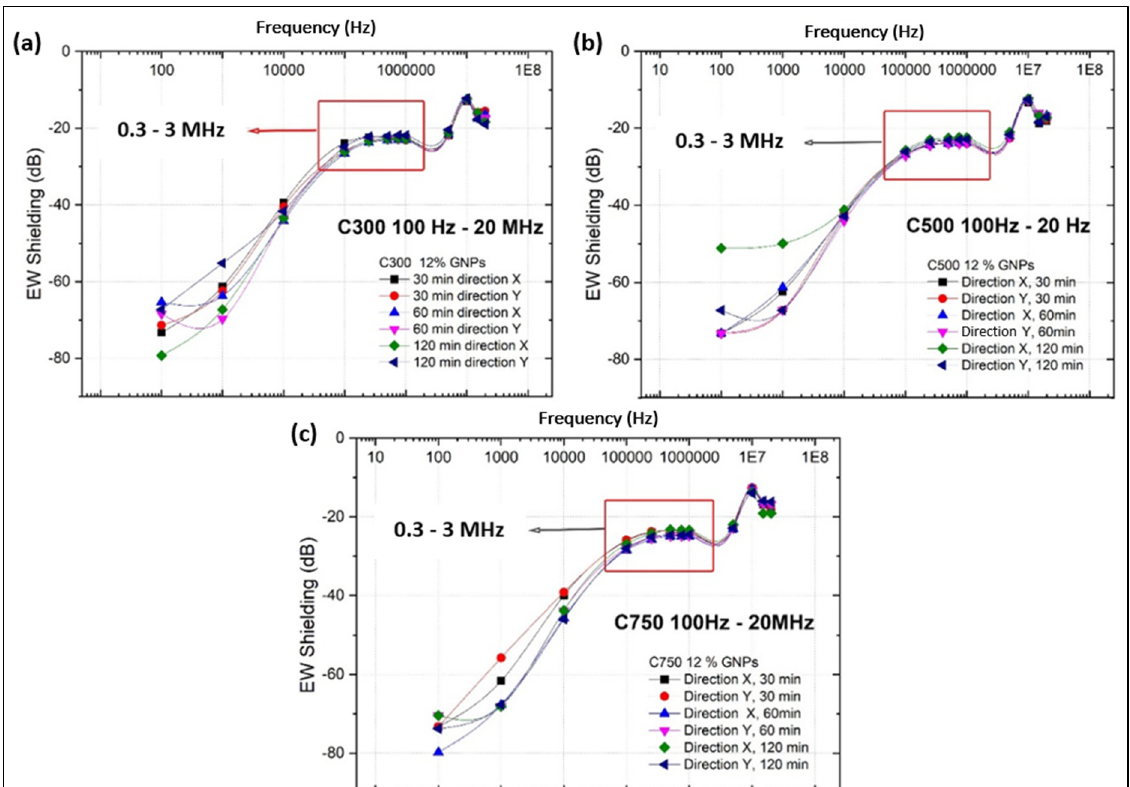
Figure 16. Electrical signal shielding value according to sonication time and transverse propagation direction in the low, medium, and high frequency bands for GNP C300 ( a ), C500 ( b ), and C750 ( c ).